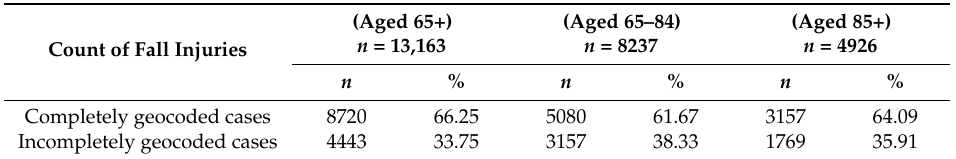
Table 1. Number and percentages of fall injuries in the City of San Antonio, by age category and geocoded status,